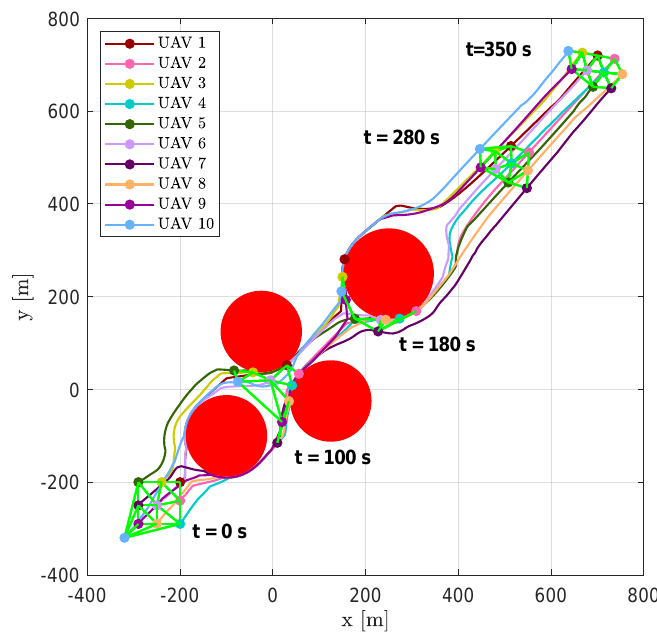
Figure 20. Scenario #2—10 aircraft: UAV trajectories. Red circles represent obstacles; colored markers indicate positions at different time instants; green straight lines highlight DTG arcs.